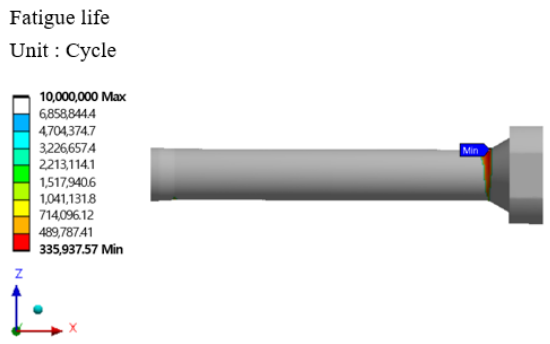
Figure 31. Von-mises stress of stem at 500 °C.